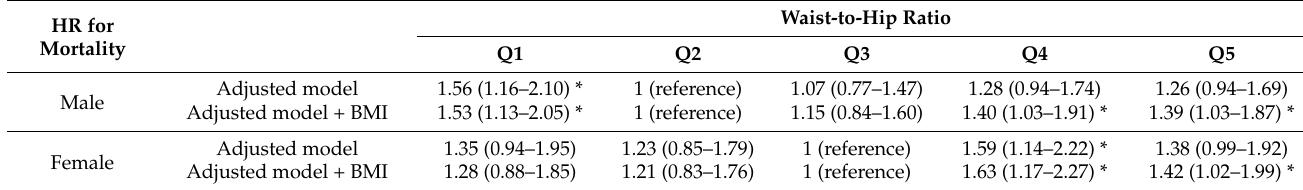
Table 4. HRs for mortality according to